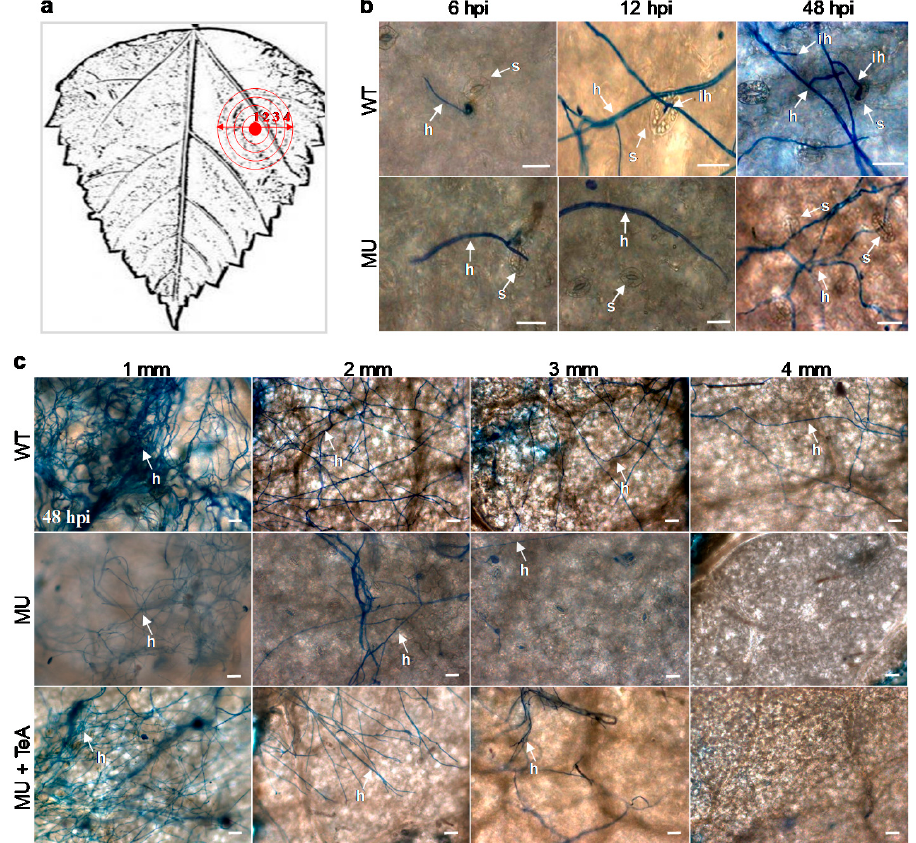
Figure 4. TeA is important for invasive hyphal growth and development of A. alternata . A. adenophora leaves were inoculated by A. alternata wild-type (20 µ L, WT), mutant ∆ HP001 (20 µ L, MU) mycelial homogenates or MU mycelial homogenates (20 µ L) with 20 µ g mL − 1 TeA (10 µ L) (MU + TeA) and incubated at 25 ◦ C for the indicated times. ( a ) Experimental model of mycelial inoculation and sample collection. The red closed circle in the center indicates the direct-contact site of mycelial inoculation on the surface of leaves; the red open circles indicate the demarcations of an area around the primary inoculation site. Here, 1, 2, 3, and 4 represent the circle with a radius of 1, 2, 3, and 4 mm from the primary inoculation site outwards, respectively. ( b ) Hyphal growth and penetration during the early-stage of A. adenophora infection by A. alternata WT or MU mycelial homogenates. Shown are visual differences in hyphal penetration between A. alternata WT and MU. ( c ) The effect of TeA on invasive hyphal growth and distribution of A. alternata on A. adenophora leaves. Shown are visible differences in invasive hyphal growth and extension between A. alternata WT, MU, and MU with TeA. Tissues were stained with lactophenol-trypan blue to visualize hyphae. Here, s: Stomata; h: Hypha; ih: Invasive hypha. Scale bars = 20 µ m. Experiments were repeated at least three times with similar